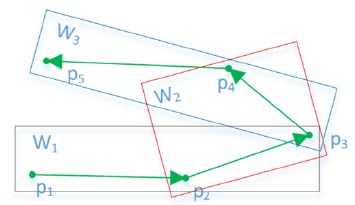
Figure 3. Multiple moving interpolation smoothing. A trajectory is composed by fine line segments, the green arrows represent their direction, five green dots are the sample points of the trajectory. Black, red and blue boxes are three sliding windows, each window contains three points. Three sliding windows are used to determine whether p 3 is a noise point.